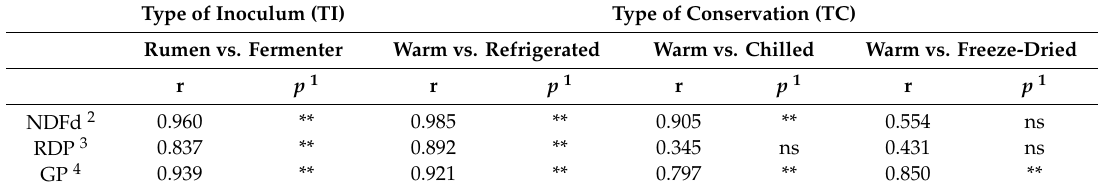
Table 4. Pearson correlation coe ffi cients (r) of in vitro data obtained for the six feeds used as substrates in two fermentation run (12 observations) by using inocula di ff ering for origin and for conservation. Type of Inoculum (TI) Type of Conservation (TC) Rumen vs. Fermenter Warm vs. Refrigerated Warm vs. Chilled Warm vs. Freeze-Dried r p 1 r p 1 r p 1 r p 1 NDFd 2 0.960 ** 0.985 ** 0.905 ** 0.554 ns RDP 3 0.837 ** 0.892 ** 0.345 ns 0.431 ns GP 4 0.939 ** 0.921 ** 0.797 ** 0.850